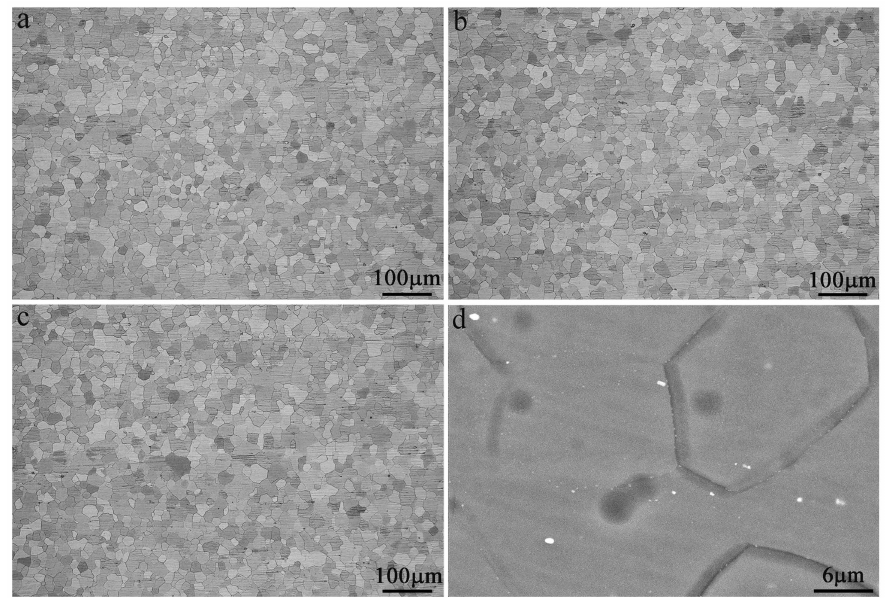
Figure 10. Optical images of the ( a ) longitudinal section, ( b ) outside surface and ( c ) cross section of the single-aged ZM51 alloy, and ( d ) SEM image of the outer surface of the single-aged ZM51